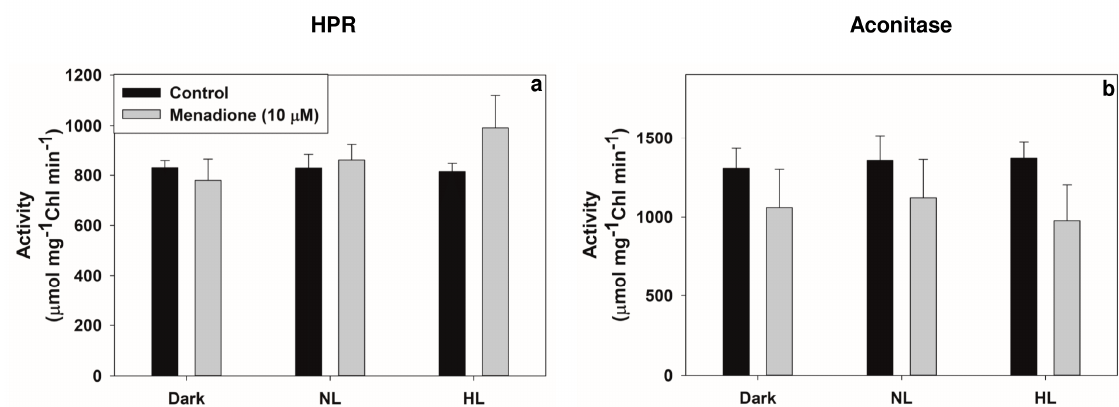
Figure 8. The activities of two photorespiratory enzymes, peroxisomal hydroxypyruvate reductase, HPR ( a ) and mitochondrial aconitase ( b ) in extracts from MD (10 µM) treated leaf samples.